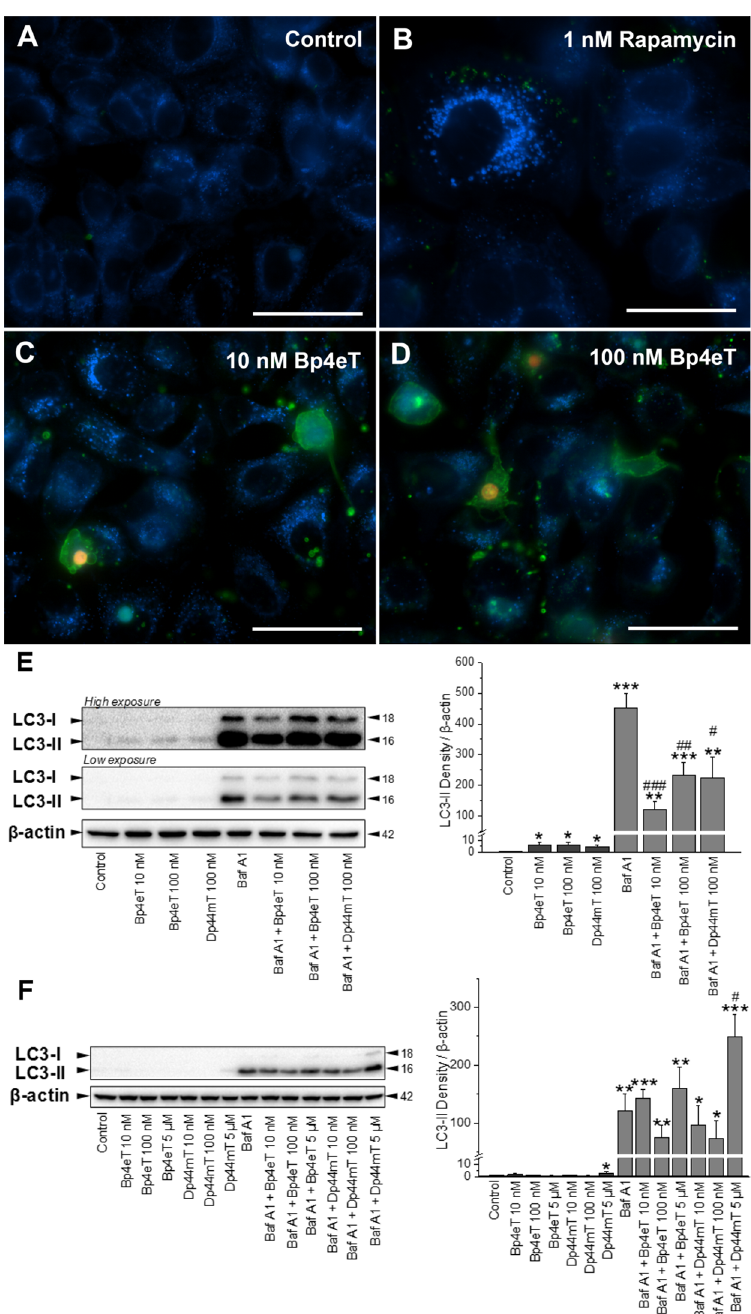
Fig 4. Epifluorescence microscopy and immunoblot estimation of autophagy, apoptosis, or necrosis after incubation with Bp4eT. MCF-7 cells were incubated at 37°C with either: (A) Control medium for 72 h; (B) Rapamycin (1 nM) for 30 min to serve as a positive control for autophagy; or (C, D) 10 or 100 nM Bp4eT for 72 h. Scale bars represent 50 μ m. (E) MCF-7 cells were incubated for 72 h/37°C with either: control medium, or medium containing 10 or 100 nM Bp4eT, 100 nM Dp44mT, or 100 nM Bafilomycin A1 alone, or the combination of chelators and Bafilomycin A1. Western blotting and subsequently densitometry was then performed to assess LC3-I/II expression. As there was a marked difference in ability of Bafilomycin A1 and the chelators to up-regulate LC3-II levels, the blots are shown at both low and high exposures. (F) MCF-7 cells were incubated for 24 h/37°C with either: control medium or this medium containing either: Bp4eT (10 nM – 5 μ M), Dp44mT (10 nM – 5 μ M), or Bafilomycin A1 (100 nM) alone, or the combination of the